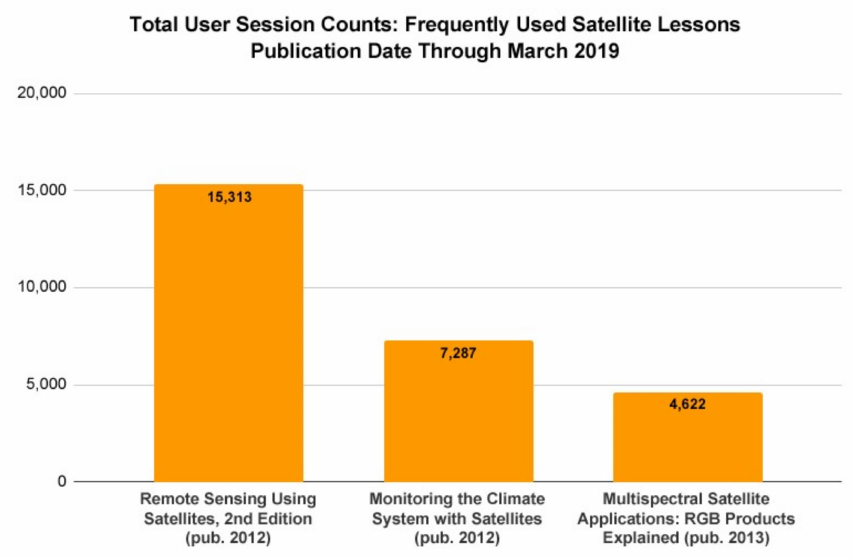
Figure 14. The bar chart shows total user session counts for three frequently used satellite meteorology lessons on MetEd. The metrics are from publication date (shown following the title below each bar) through March